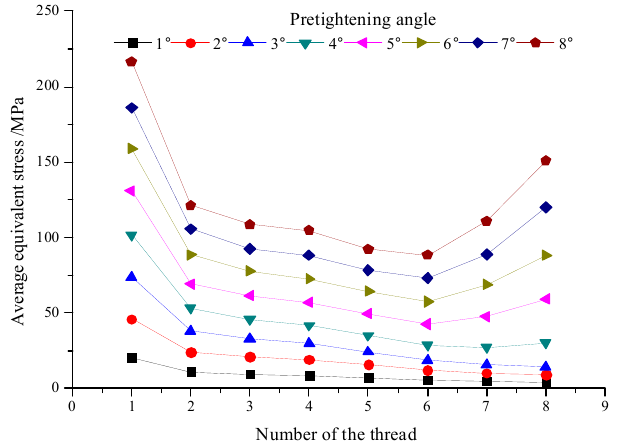
Figure 14. Relationship between the average equivalent thread stress and the pretightening angle.